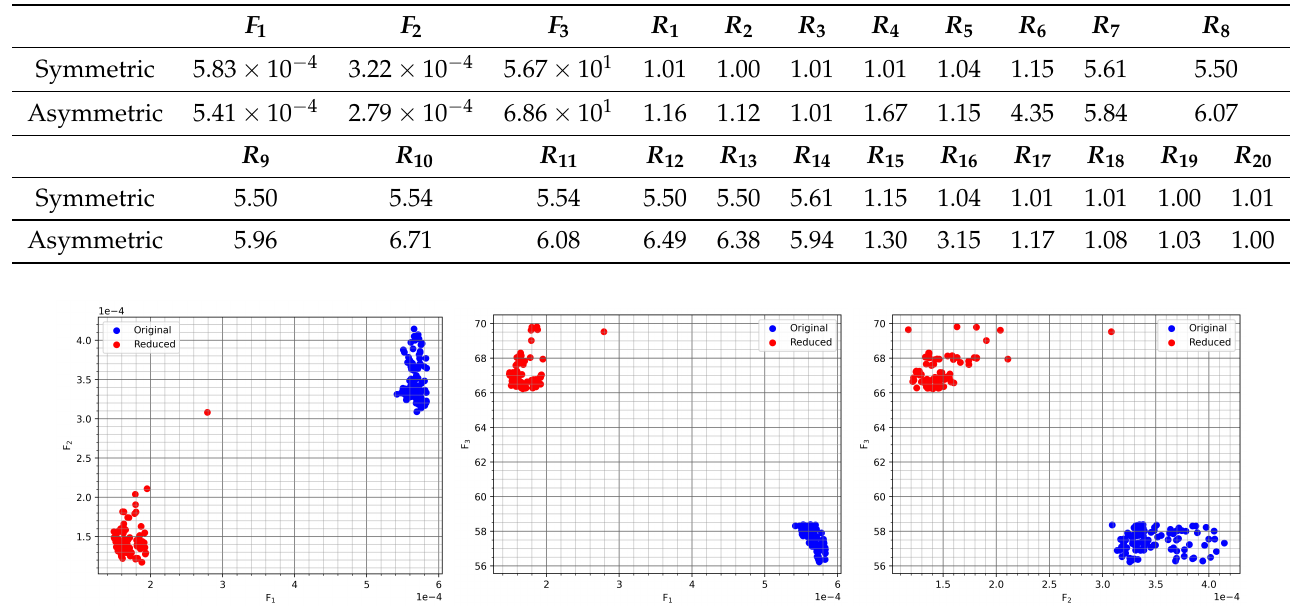
Table 7. Last individual in case (a).